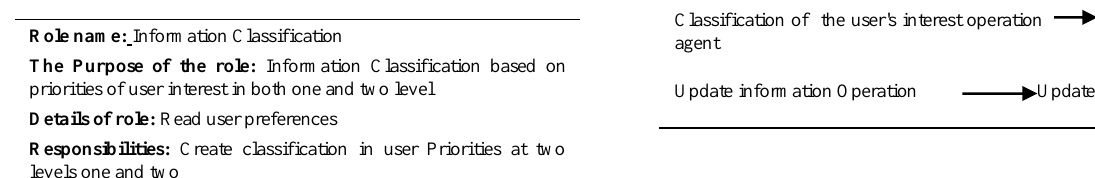
Table 10. Role model for the classification role.